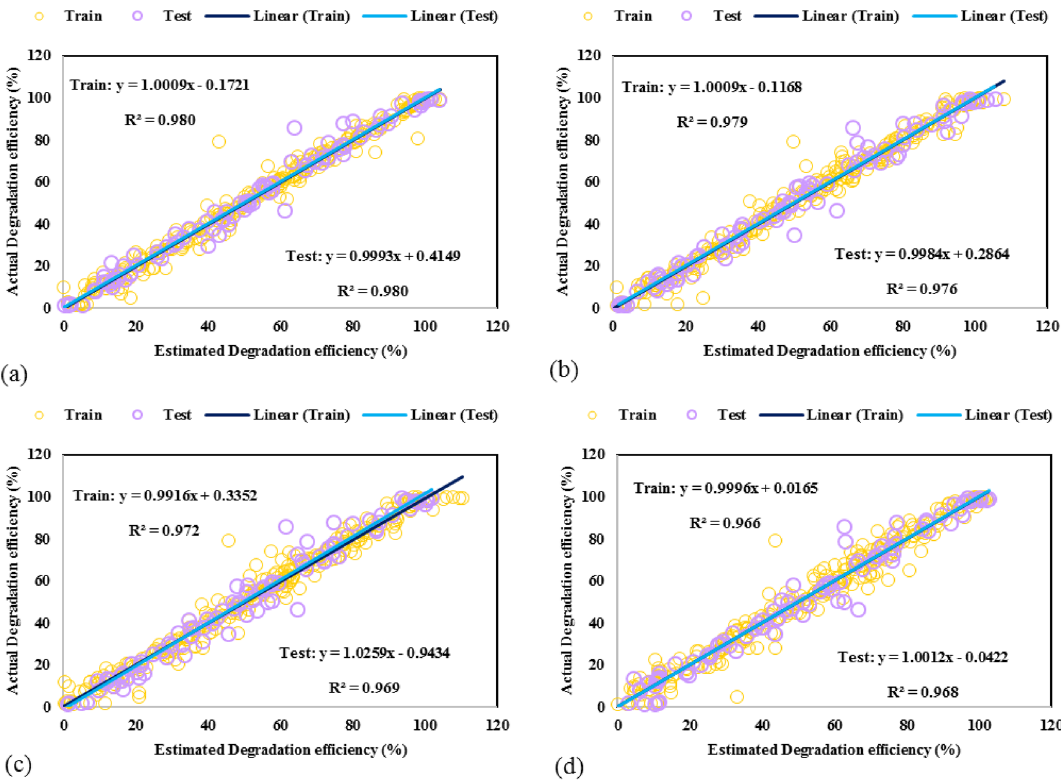
Figure 4. Cross plots for GPR model containing kernel function of (a) exponential, (b) matern, (c) squared exponential, (d) rational